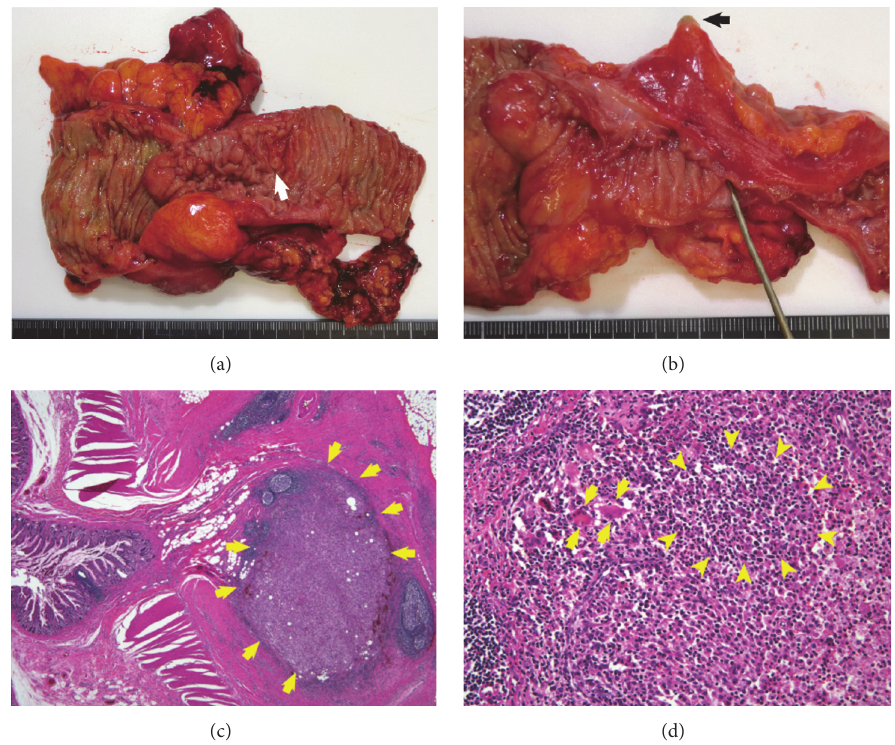
Figure 3: Surgically resected specimen revealed diverticula on the mesenteric side in the terminal ileum ((a) and (b)). Microscopically, the nodular areas correspond to points of mucosal invagination into the surrounding muscular layer, creating diverticula (c). There is inflammatory granuloma that consisted of foreign body giant cells (arrows in (d)) and foam cells (arrow heads in (d)) in the invaginated